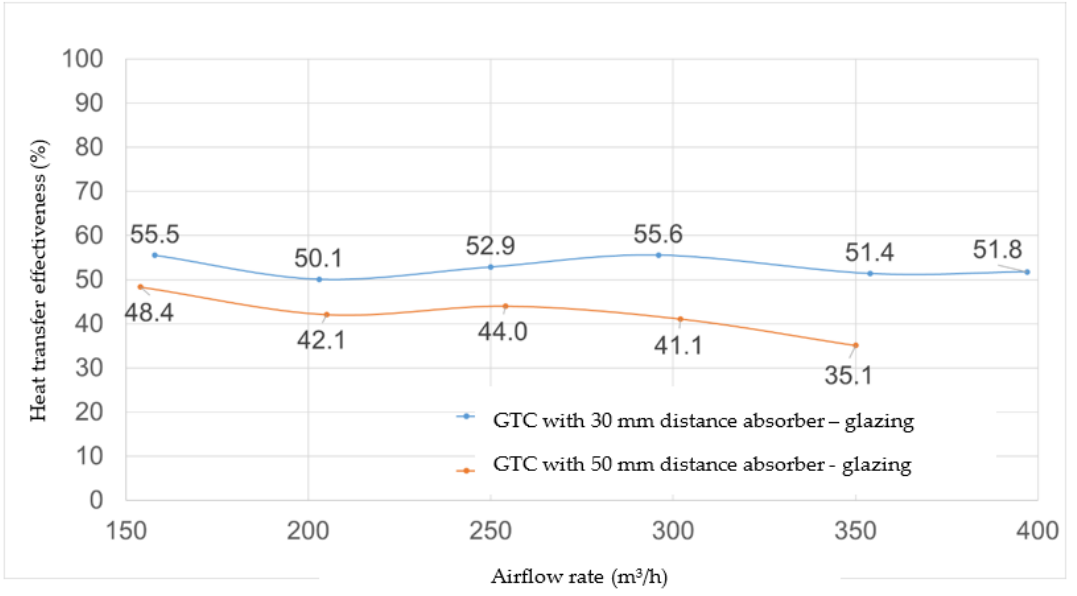
Figure 4. GTC heat transfer effectiveness.